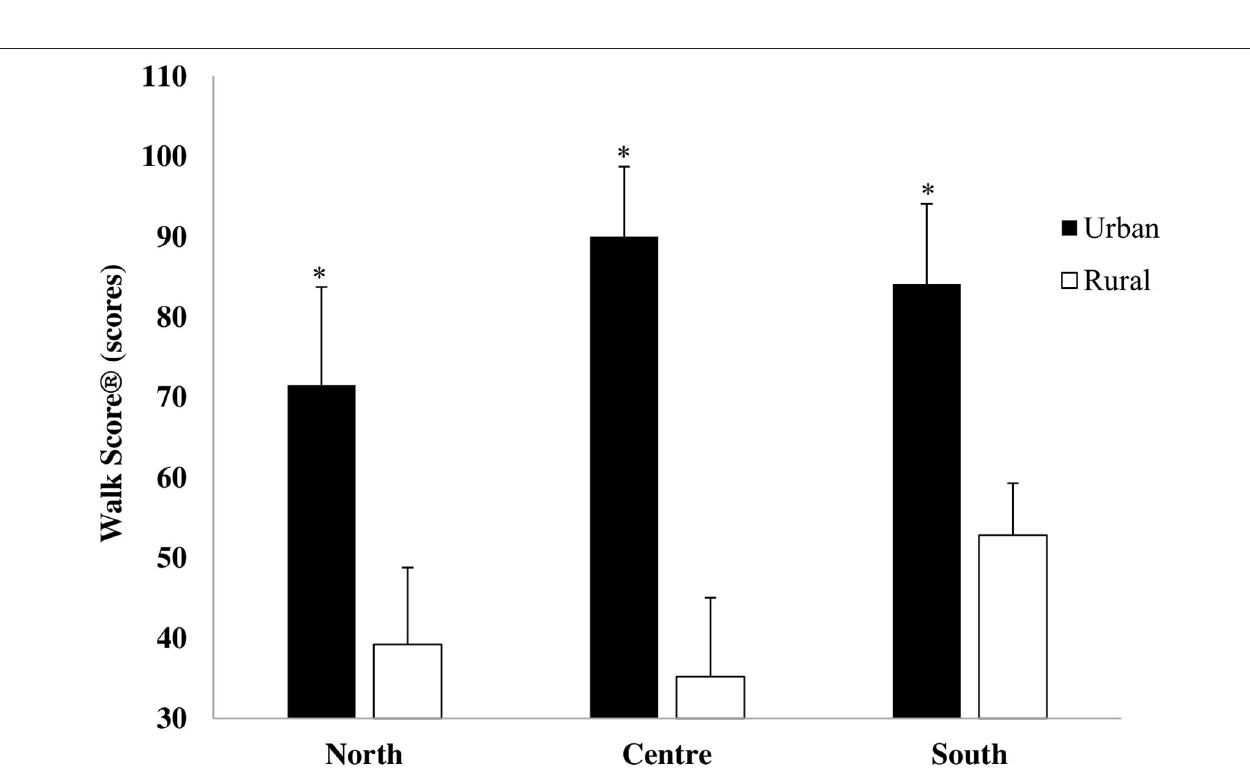
Frontiers in Pediatrics |